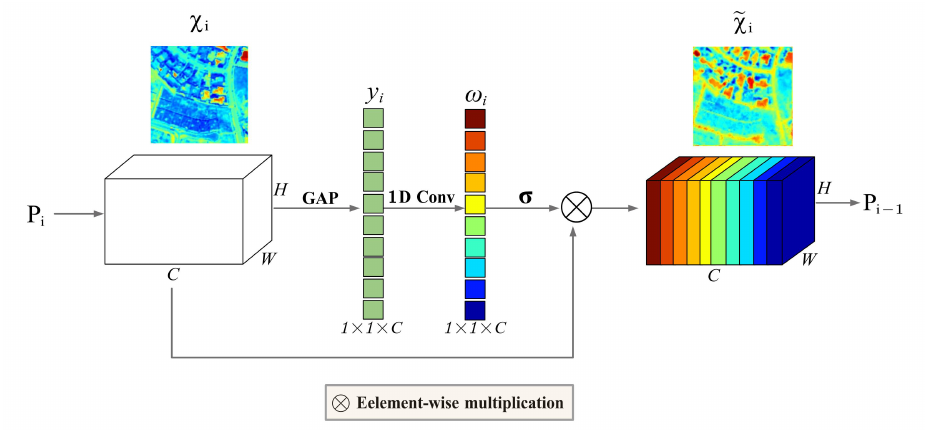
Figure 3. Structure of AFPN. P i is the i -th layer of